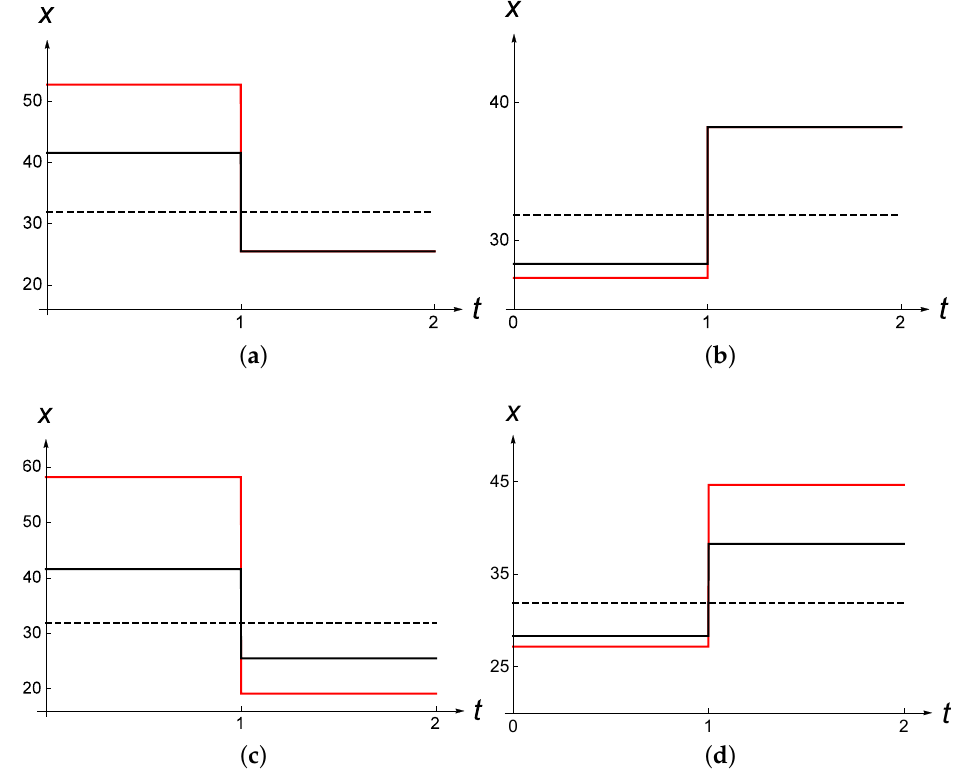
Figure 7. We plot the optimal investment boundary b ( t ) = b 1 I ( t < τ ) + b 2 I ( t ≥ τ ) w.r.t. λ and γ . The parameter set is r = δ = 0.03, σ = 0.3, K 1 = 10, K 2 = K 1 ( 1 + γ ) . For λ > 0, we assume jump occurs at τ = 1. ( a ) upper-left: for λ = 0 (dashed line), λ = 0.2 (black line), λ = 0.4 (red line) when γ = − 0.2; ( b ) upper-right: for λ = 0 (dashed line), λ = 0.2 (black line), λ = 0.4 (red line) when γ = 0.2; ( c ) lower-left: for γ = 0 (dashed line), γ = 0.2 (black line), γ = 0.4 (red line) when λ = 0.2; ( d ) lower-right: for γ = 0 (dashed line), γ = 0.2 (black line), γ = 0.4 (red line) when λ =